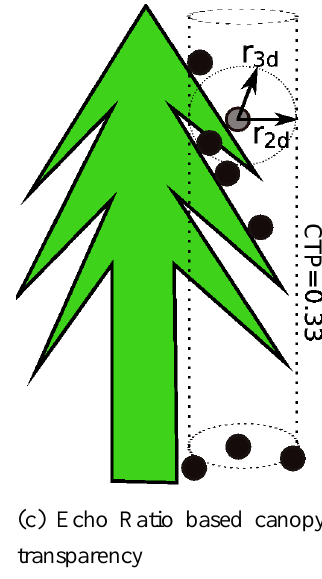
Figure 2. Illustration of the canopy transparency parameters (CTPs), which are applied to every first echo laser point. In (a) a static search radius, in (b) a dynamic search radius depending on the sample plot first echo point density is used to calculate the canopy transparency towards the laser echoes. The canopy transparency parameter in (c) is based on the Echo Ratio (ER).